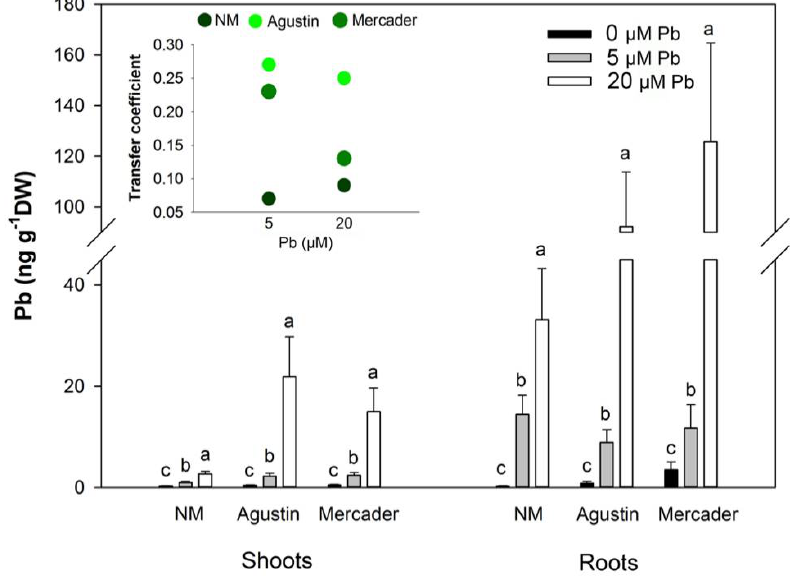
Figure 2. Pb content in roots and shoots and Pb transfer coefficient of NM and M (Agustin and Mercader) Z. fabago seedlings exposed to 0, 5 and 20 µM Pb(NO 3 ) 2 for 4 weeks. Values are given as mean ± SE. Different letters correspond to significant differences between Pb doses within the same population and organ.